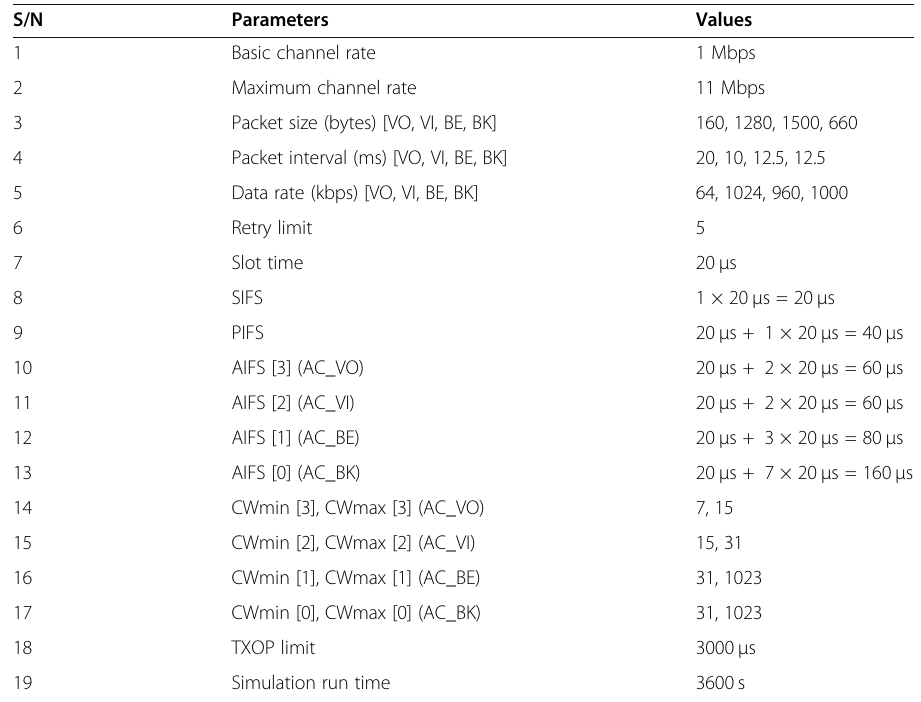
Table 3 Simulation parameters